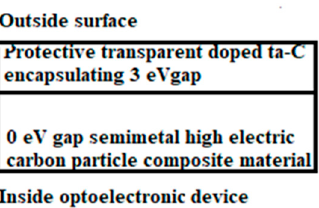
Figure 19. Scheme of conducting system with little conducting doped ta-C coating on highly electric conducting composite graphene.